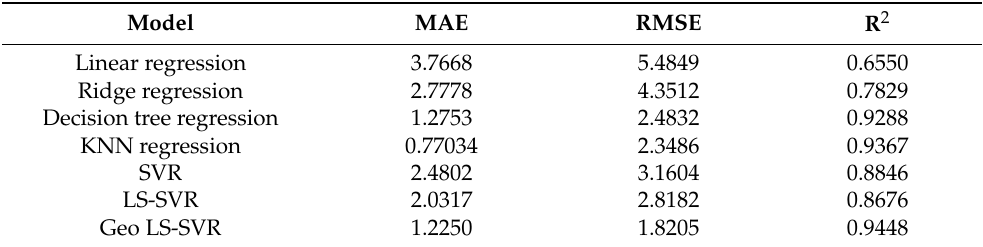
Table 4. Evaluation index value comparison between the numeric-type Geo LS-SVR model and traditional